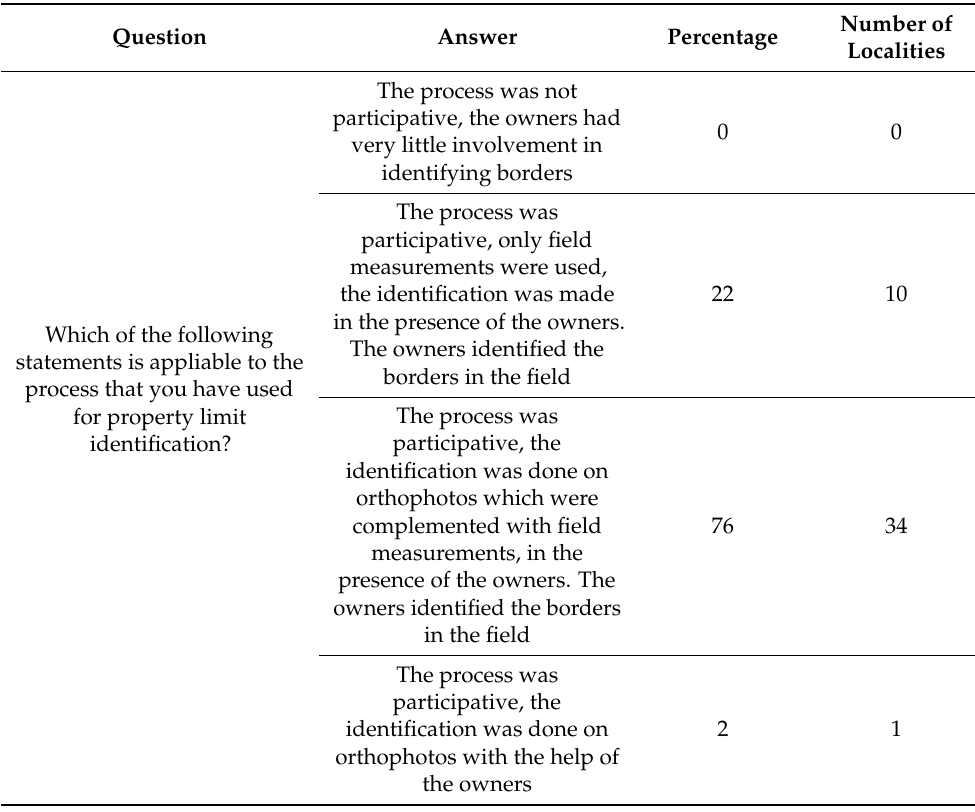
Table 5. Assessment of the people’s participation in the project.